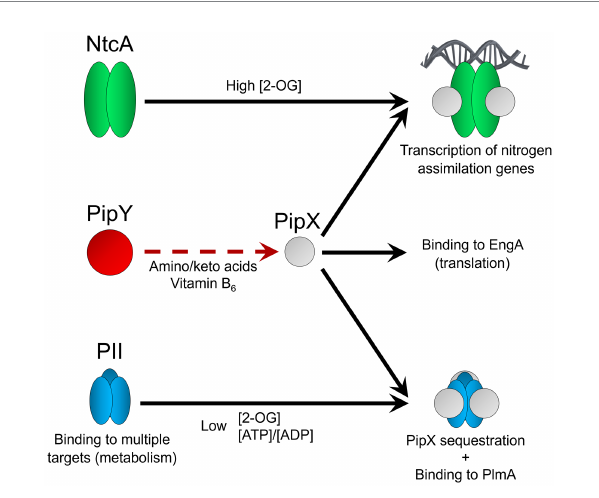
FIGURE 1 PipX swapping between PII and NtcA and putative role of PipY. The role of NtcA or PII effectors on interactions with PipX is illustrated with black solid arrows pointing toward the complexes. Functions of these and other PII or PipX complexes are mentioned below the corresponding complexes or proteins. Interactions between PipX and PipY, proposed from genetic evidence, is illustrated by the dotted red arrow. The area of the molecules is scaled according to the number of amino acids per